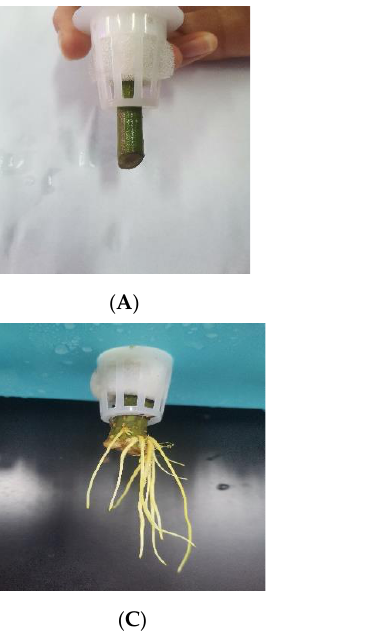
Figure 4. Database of the various stages of root growth of mulberry cuttings: ( A ) healthy samples; ( B ) samples growing healing tissue; ( C ) samples growing adventitious roots; ( D ) samples suffering from mildew disease.